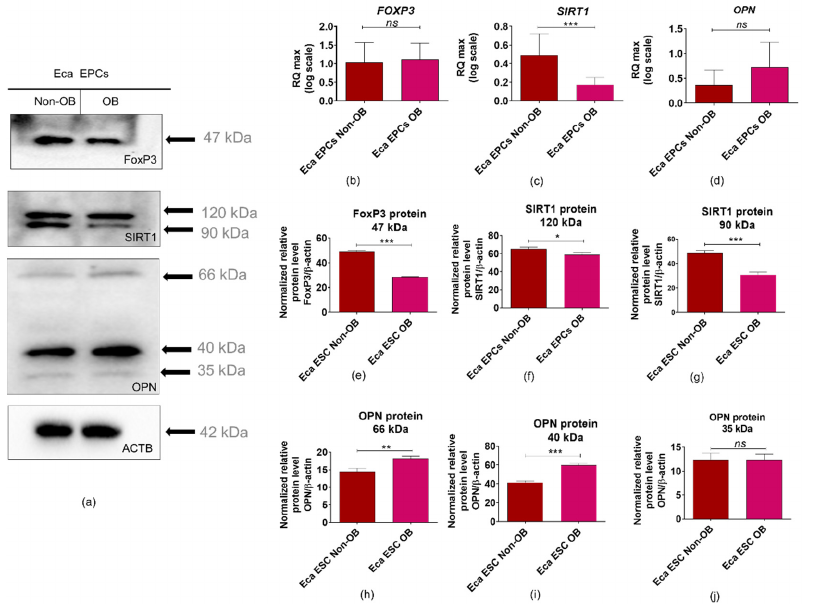
Figure 13. Expression of forkhead box P3 (FOXP3), sirtuin 1 (SIRT1) and osteopontin (OPN) deter- mined in equine endometrial progenitor cells (Eca EPCs) isolated from non-obese mares (non-OB) and obese mares (OB). The protein levels were normalized to β -actin (ACTB). Protein expression was detected using Western blot technique ( a ), while RT-qPCR ( b – d ) was used to establish the mRNA level for genes of interest. The densitometry measurements of membranes were performed to compare the expression of proteins between EPCs non-OB and OB ( e – j ). Significant differences were calculated for normalized values and shown as means ± SD. * p -value < 0.05 and ** p -value < 0.01 and *** p -value < 0.001. We noted an increased constitutive expression of AKT/PI3K in Eca EPCs derived from obese mares (Figure 14). The analysis of mRNA levels determined for AKT and PI3K indicated the increased accumulation of those transcripts in Eca EPCs OB (Figure 14d,g).